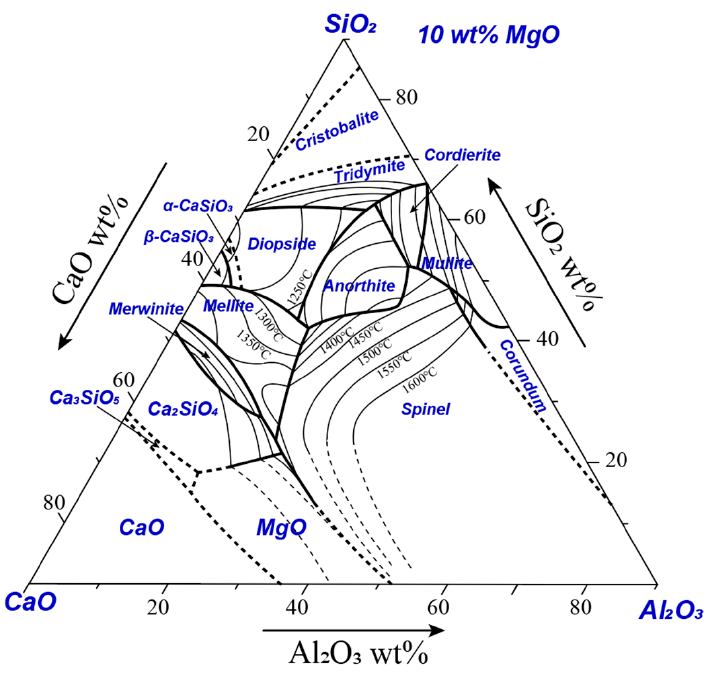
Figure 7. The 10% MgO plane of the system CaO-MgO-Al 2 O 3 -SiO 2 [8].